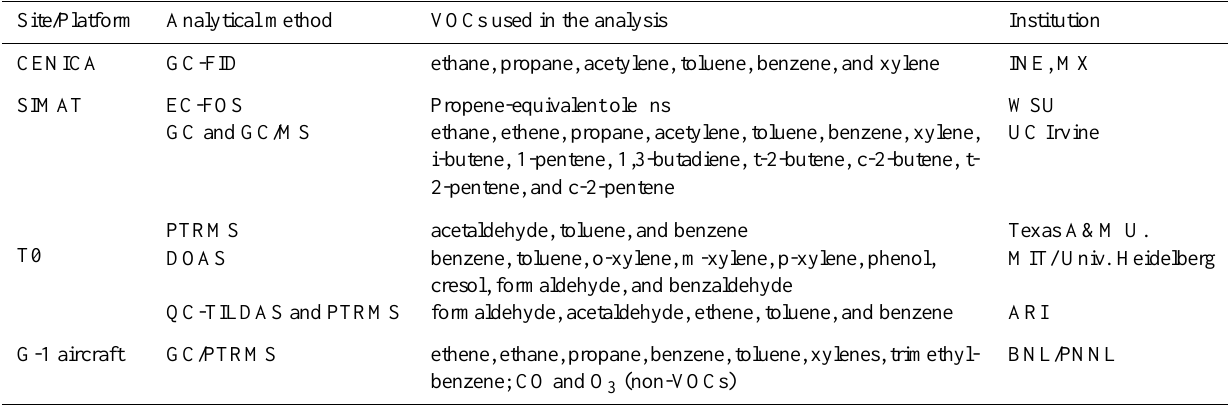
Table 1. VOC measurements during the MILAGRO campaign that were used in this study.